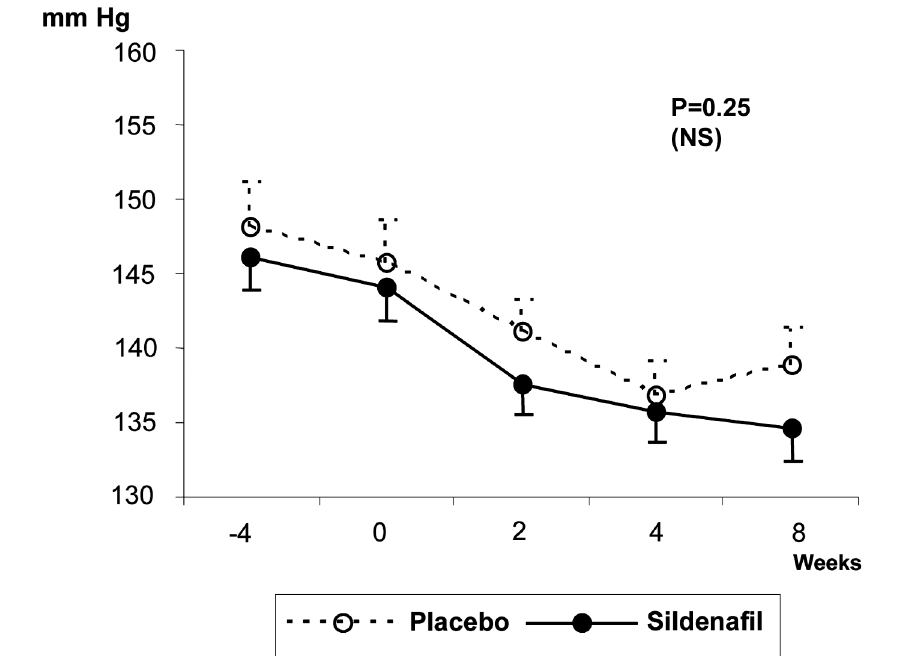
Figure 5 – Blood pressure (BP) behavior during the study. Systolic BP in sitting position. P values refer to the comparisons between sildenafil and placebo. NS = not